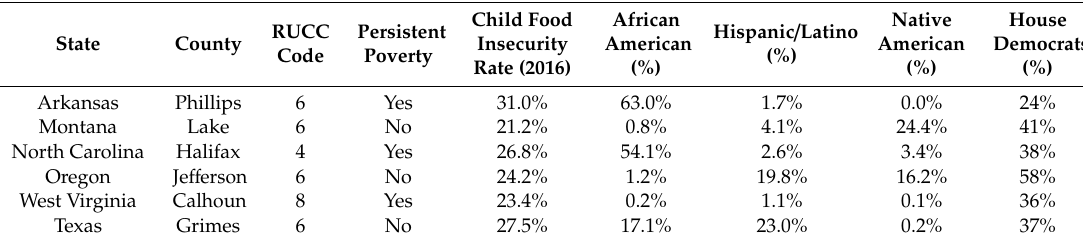
Table 1. Study County Characteristics (N =